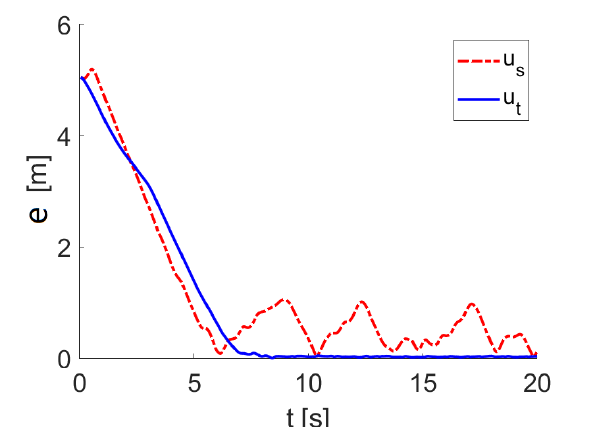
Figure 10. Errors of the position regulation obtained by u s and u t for the AUV of F t .